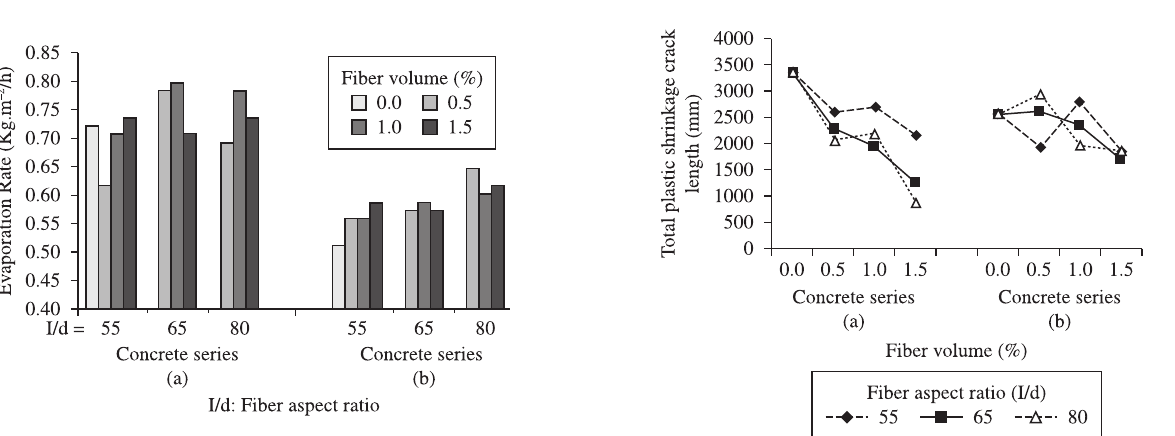
Figure 2. Effect of fiber volume and fiber aspect ratio on water evaporation rate for series A and series B concretes.